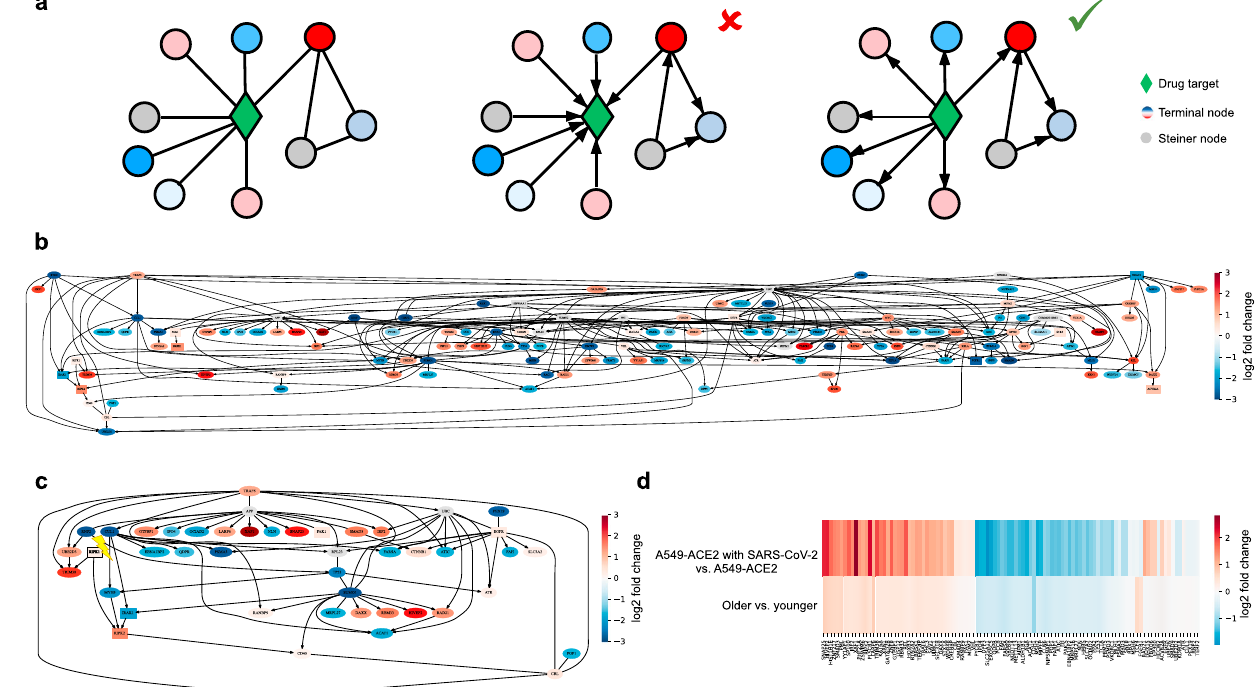
Fig. 5 Causal mechanism discovery of potential drug targets. a In an undirected protein – protein interaction network (left), edge directions for a particular drug target (green diamond) are unknown. Establishing causal directions is important since it is of interest to avoid drug targets that do not have many downstream nodes in the disease interactome (middle) and instead choose drug targets that have a causal effect on many downstream nodes in the disease interactome (right). b Causal network underlying the combined SARS-CoV-2 and aging interactome in A549 cells with gene targets of selected drugs in boxes (largest connected component shown). c Causal subnetwork of A549 cells corresponding to nodes within fi ve nearest neighbors of RIPK1 (highlighted with lightning bolt). Drug targets are represented by boxes. In a – c , the node color corresponds to the log 2 -fold change of expression in A549- ACE2 cells with SARS-CoV-2 infection versus without SARS-CoV-2 infection. Gray nodes represent Steiner nodes. d Heatmap of log 2 -fold change of genes that are downstream of